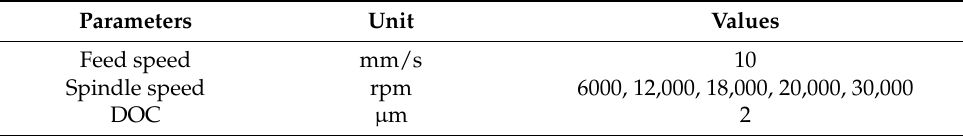
Figure 1. ( a ) Experimental layout of diamond micro-milling; ( b ) Optical image of the single-edge diamond ball milling tool. Table 1. Parameters of micro-milling.